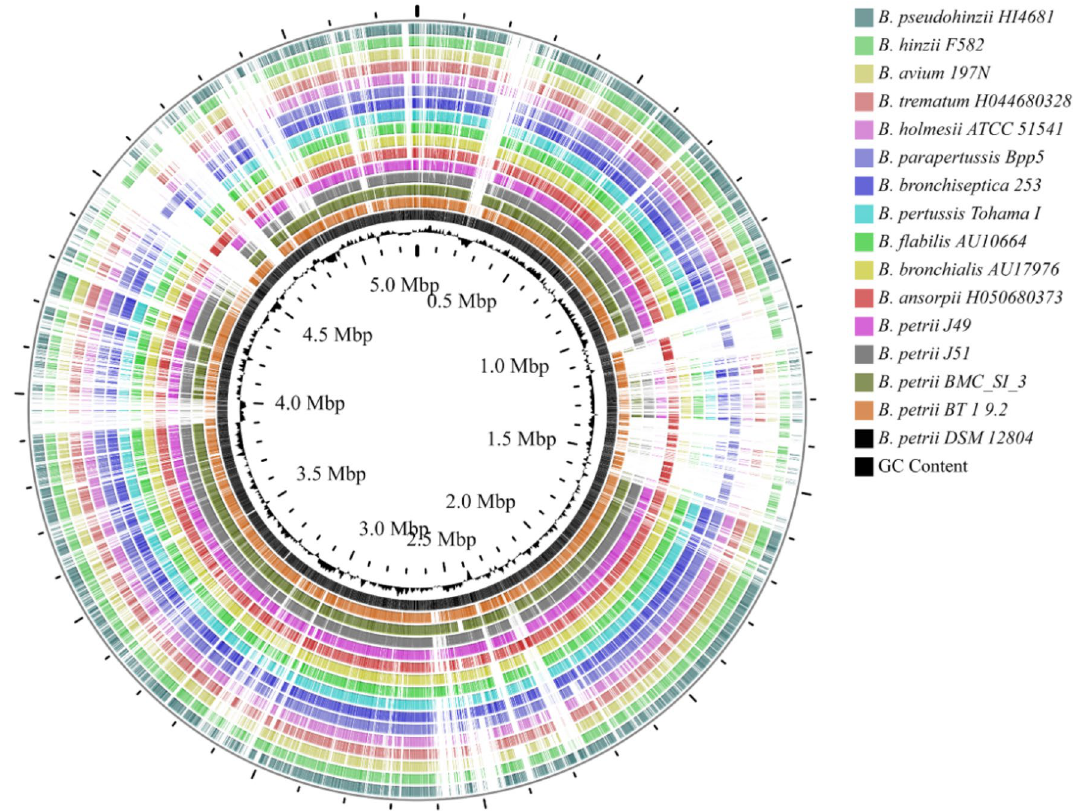
Figure 6. Blast analysis and circular genome comparison of the species of Bordetella